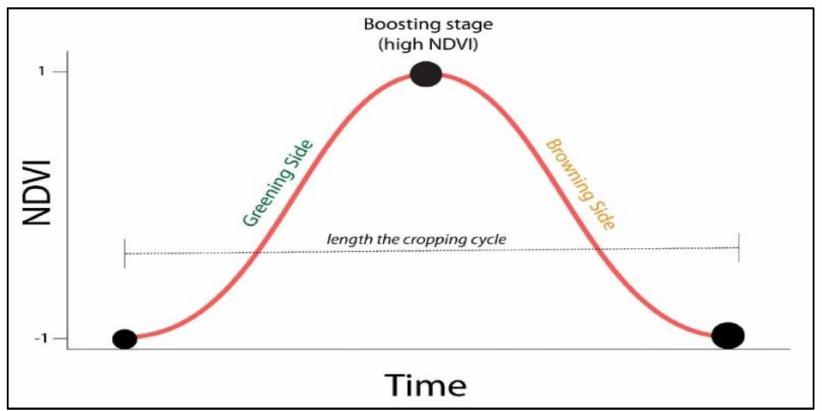
Figure 5. An example of single growing season and related phenological measures analysed through